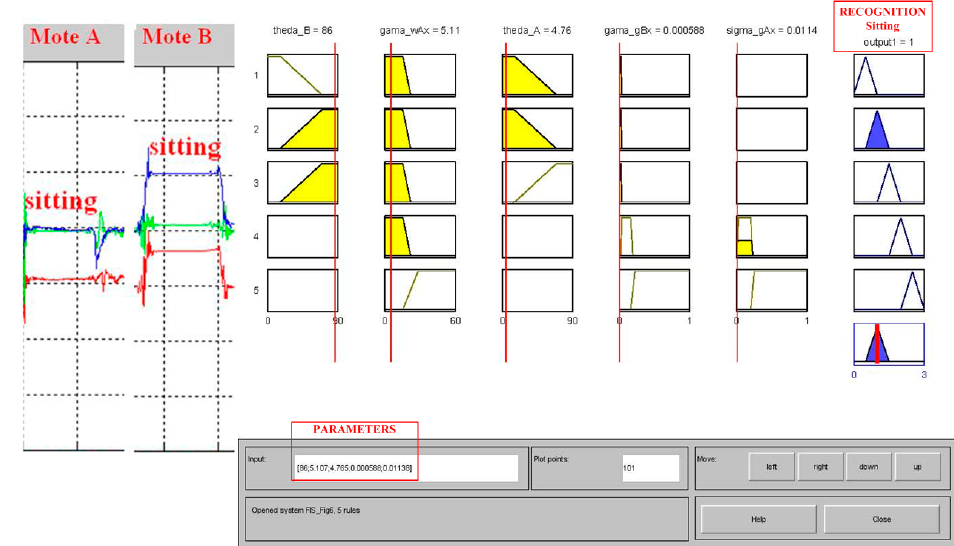
Figure 5. Substitution of fuzzy parameters for activity recognition.